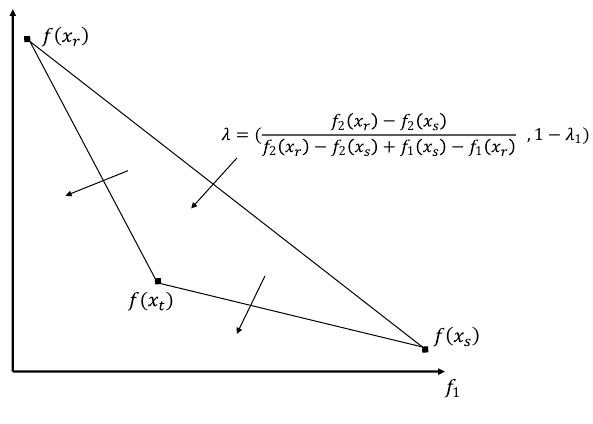
Figure 3. Illustration of Phase